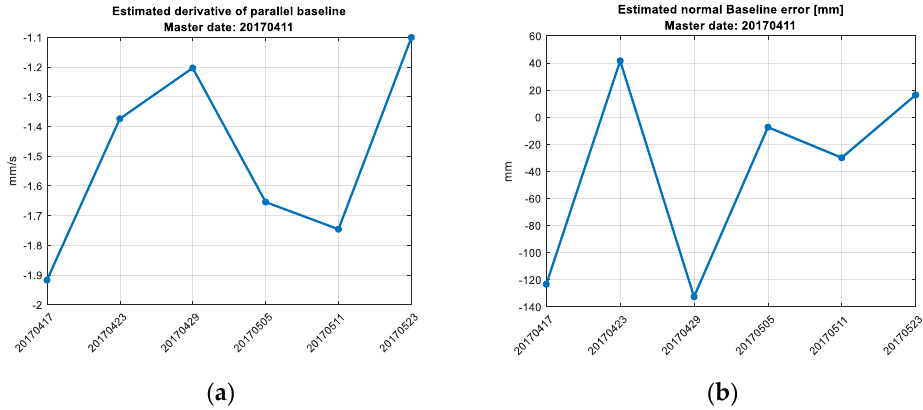
Figure 10. Orbital error parameters estimated in the six interferograms (x-axis). ( a ) Derivative of the parallel baseline. ( b ) Error in the normal baseline.